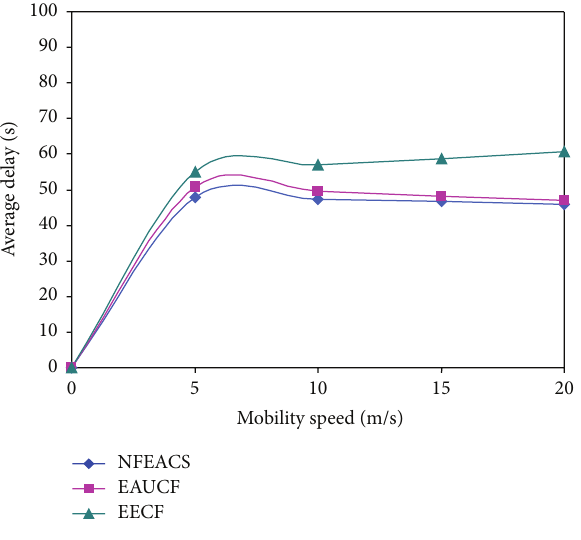
Figure 7: Mobility speed versus delay.